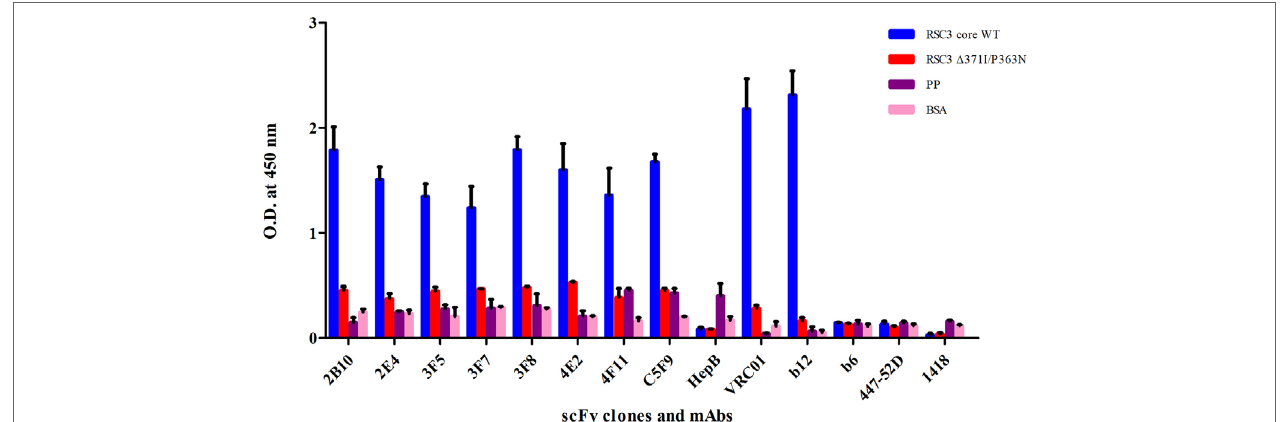
FigUre 2 | Soluble phage ELISA for the identification of anti-CD4-binding site (CD4bs) specific scFv clones. RSC3 core WT along with its mutant Δ 371I/P363N and negative control antigens PP-unrelated peptide pool and BSA was used at 2 µg/ml. Here, anti-CD4bs bnAbs VRC01 and b12 were used as positive controls; anti-CD4bs non-neutralizing antibody (non-nAb) b6, anti-V3 mAb 447-52D and anti-parvovirus mAb 1418 were used as negative controls along with anti-Hepatitis HepB scFv clone. The scFv Clones showing binding with RSC3 core WT antigen at least two times more than its mutant and three times than the negative control were considered as positive. The ELISA was repeated twice and mean binding titers were compared with negative